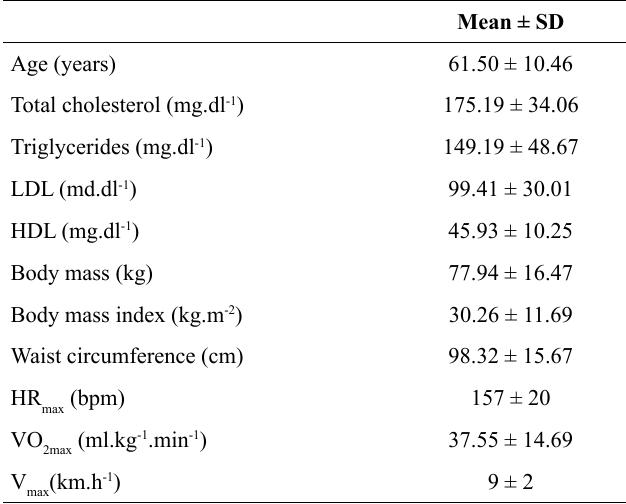
Table 1. Patients characteristics.